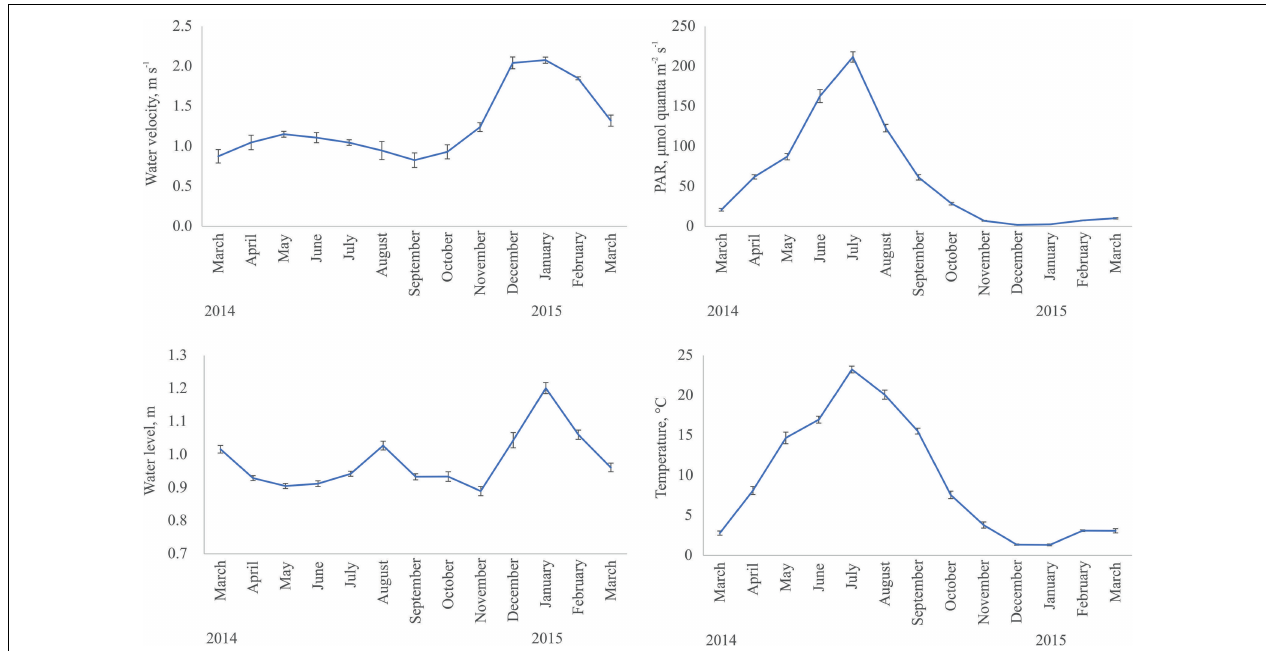
FIGURE 1 | Seasonal dynamics of abiotic environmental variables at near-bottom layer in the study area (means ± Standard Error).